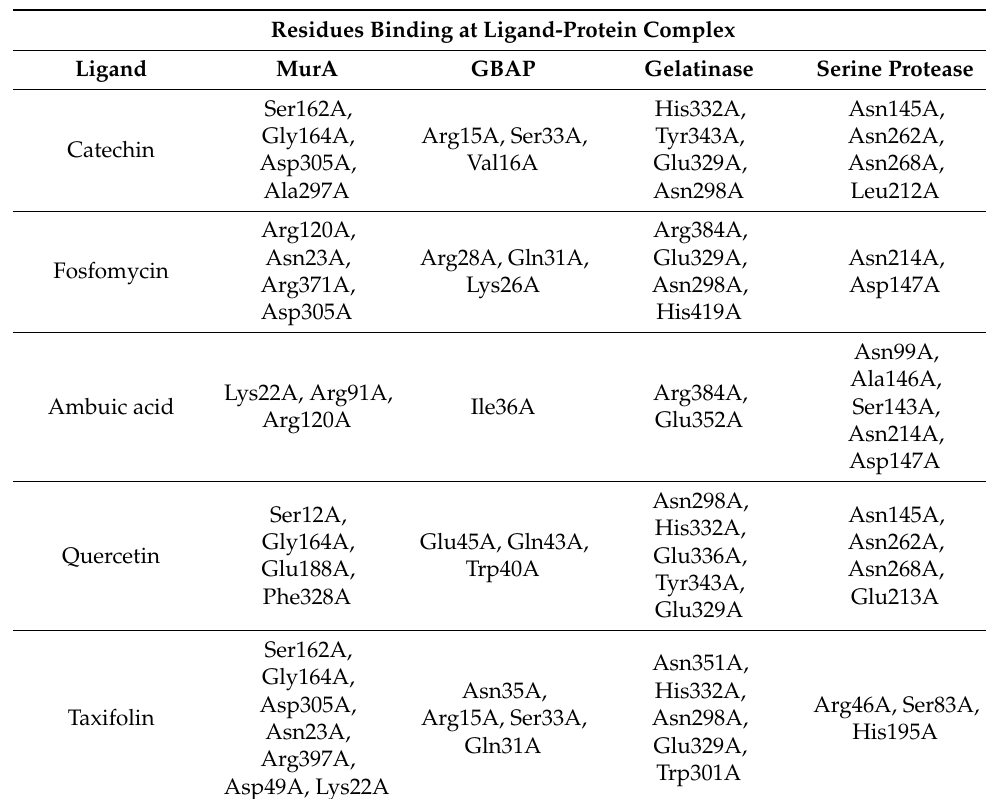
Table 5. Hydrogen bond in catechin–MurA and positive